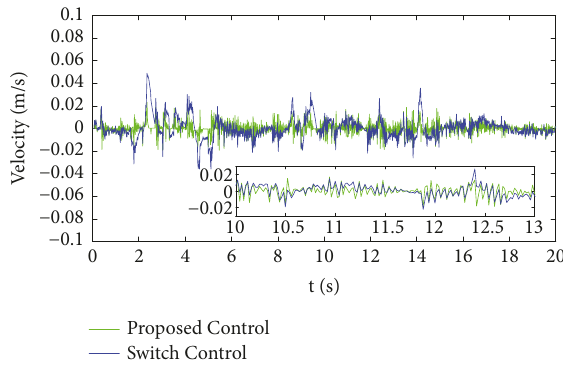
Figure 6: Velocity response of Example 2.